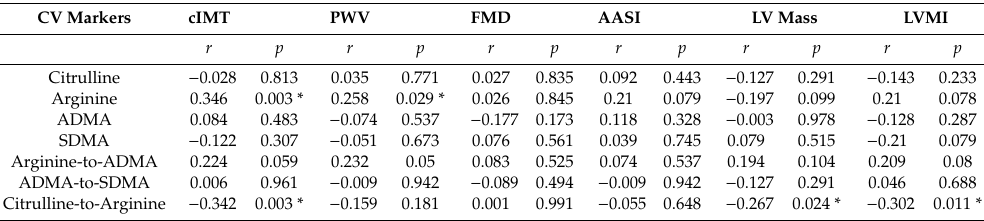
Table 6. Correlation between NO-related biomarkers and cardiovascular surrogate markers in children with CKD stage